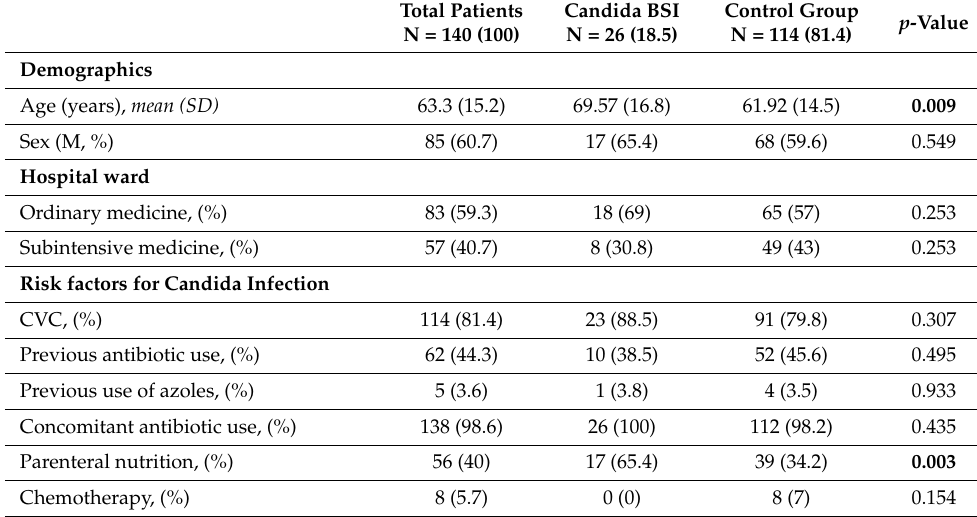
Table 1. Characteristics of the